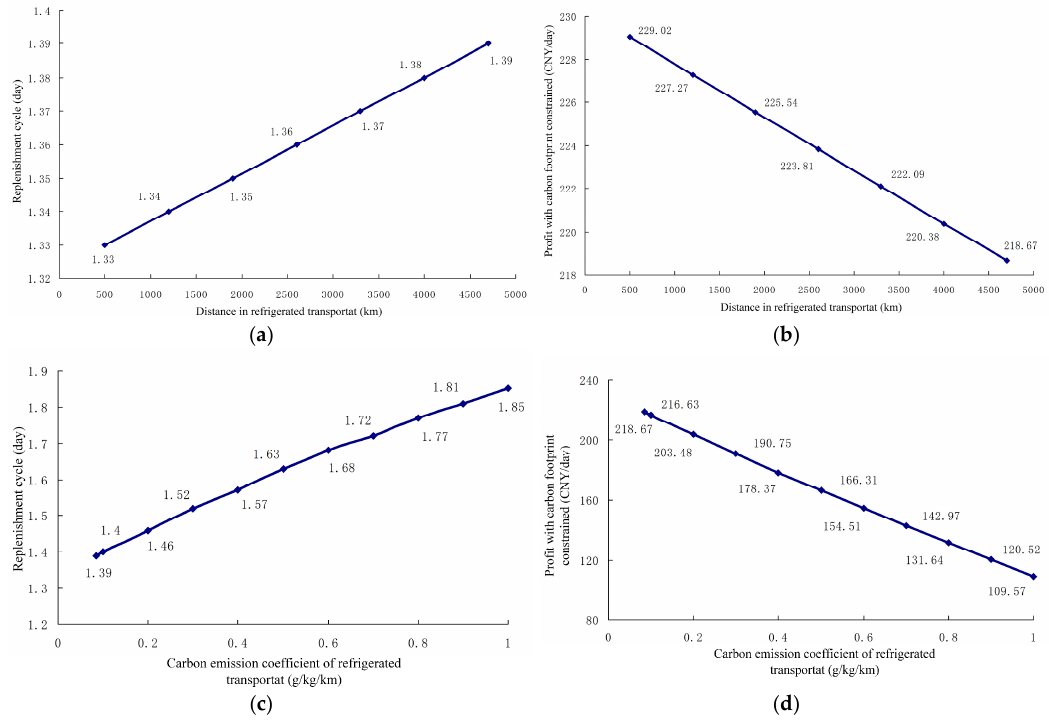
Figure 6. Influence of the distance and carbon emission coefficient in refrigerated transport: ( a ) the curve of the replenishment cycle with the distance; ( b ) the curve of the profit with carbon footprint constraint with the distance; ( c ) the curve of the replenishment cycle with the carbon emission coefficient; and ( d ) the curve of the profit with carbon footprint constraint with the carbon emission